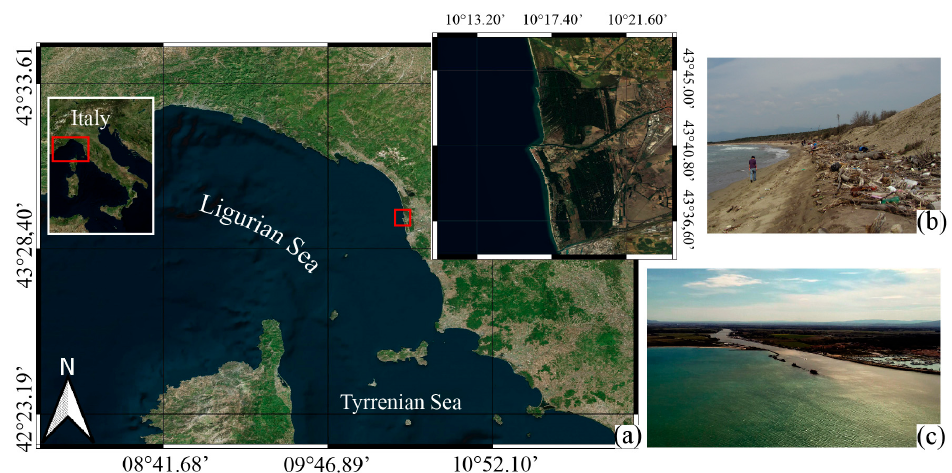
Figure 1. ( a ) The area in the zoomed square (red box in map) is the coast surrounding the Arno mouth. The shoreline of the MSMRNP panel ( b ) is located just north of the river’s mouth panel ( c ).